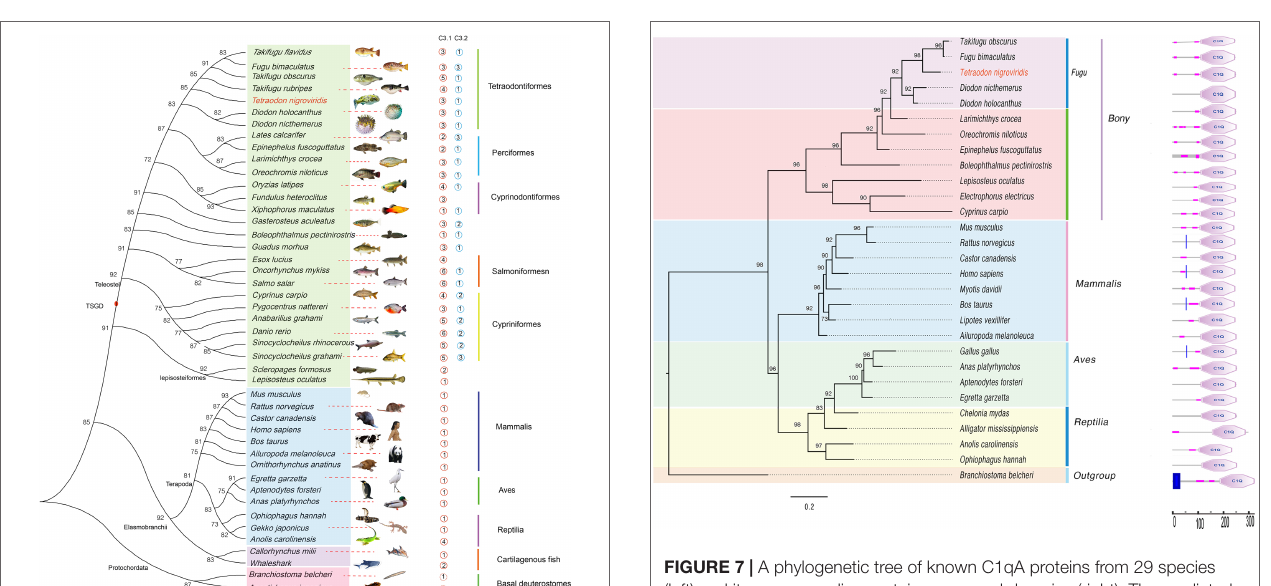
FIGURE 7 | A phylogenetic tree of known C1qA proteins from 29 species (left) and its corresponding protein conserved domains (right). The predicted protein domain architecture of the 29 C1qA genes was determined by the SMART program (Castresana,